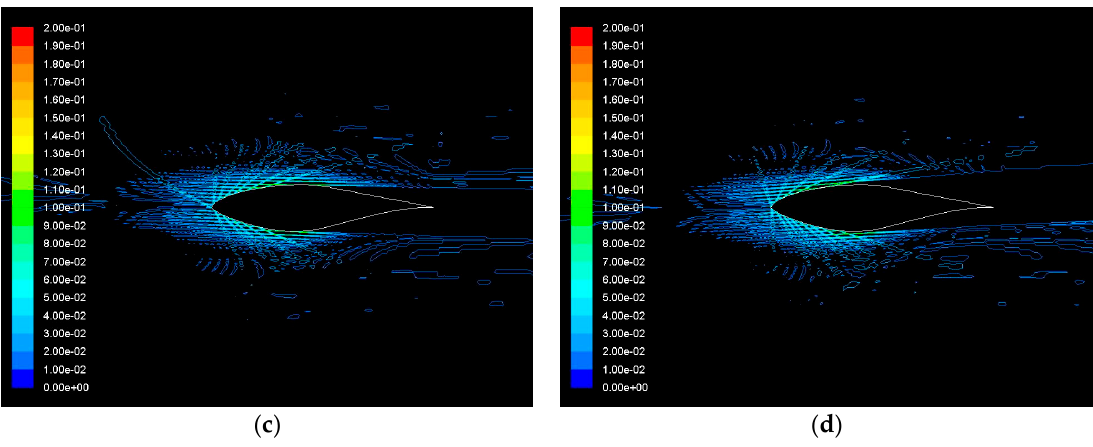
Figure 15. Contours of DPM concentration at ( a ) − 3°; ( b ) 0°; ( c ) 3°; and ( d ) 9° angles of attack at Re = 2 × 10 6 with the realizable k– ε turbulence model for an S809 airfoil for air-sand particle two-phase flow and 1% concentration of sand particles in the air.